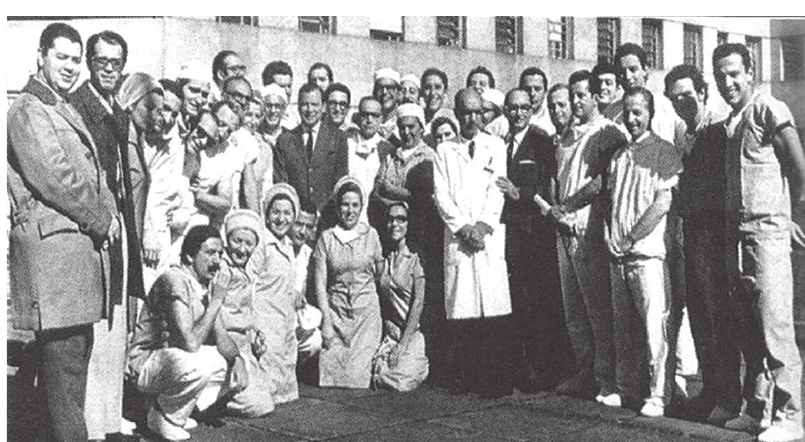
Fig. 7 – Manhã do primeiro transplante no Hospital das Clínicas, com a presença do